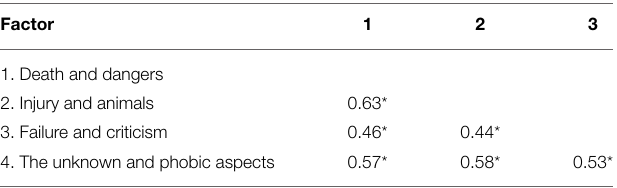
TABLE 2 | CFA correlations (coefficients) between the four dimensions of fear. Factor 1